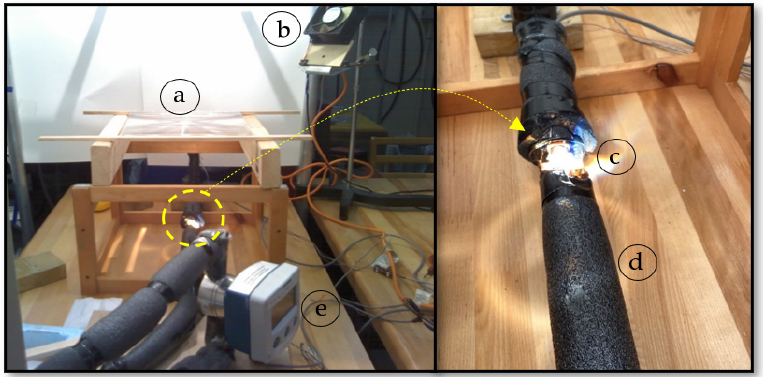
Figure 2. Photograph of the experiment test section: ( a ) Fresnel lens; ( b ) cooling fan; ( c ) MJPV; ( d ) pipe and insulator; ( e ) flowmeter. ( d ) pipe and insulator; ( e )